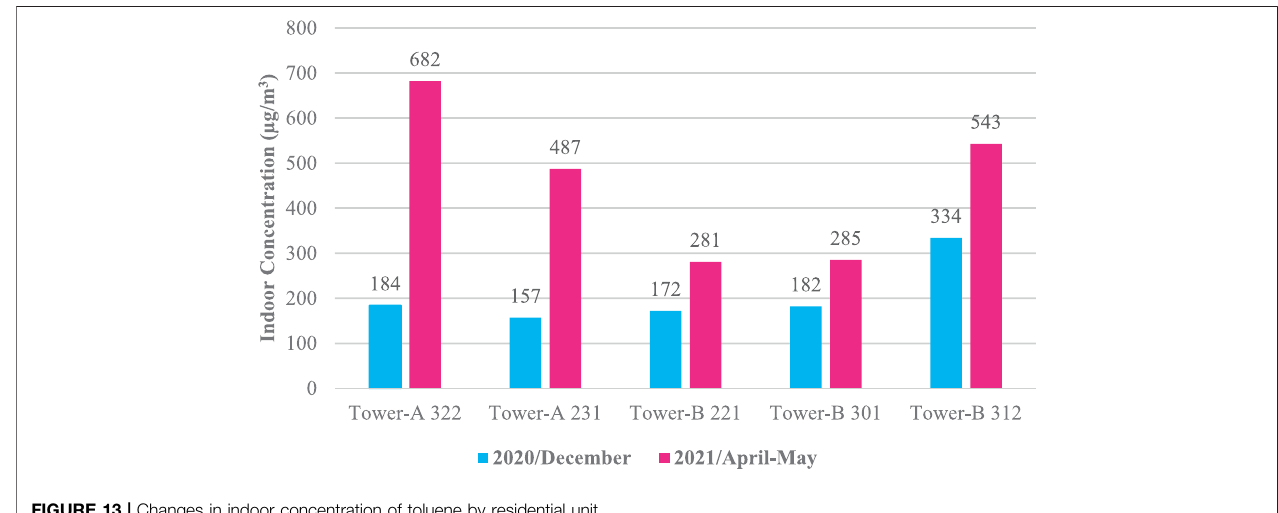
FIGURE 13 | Changes in indoor concentration of toluene by residential unit.